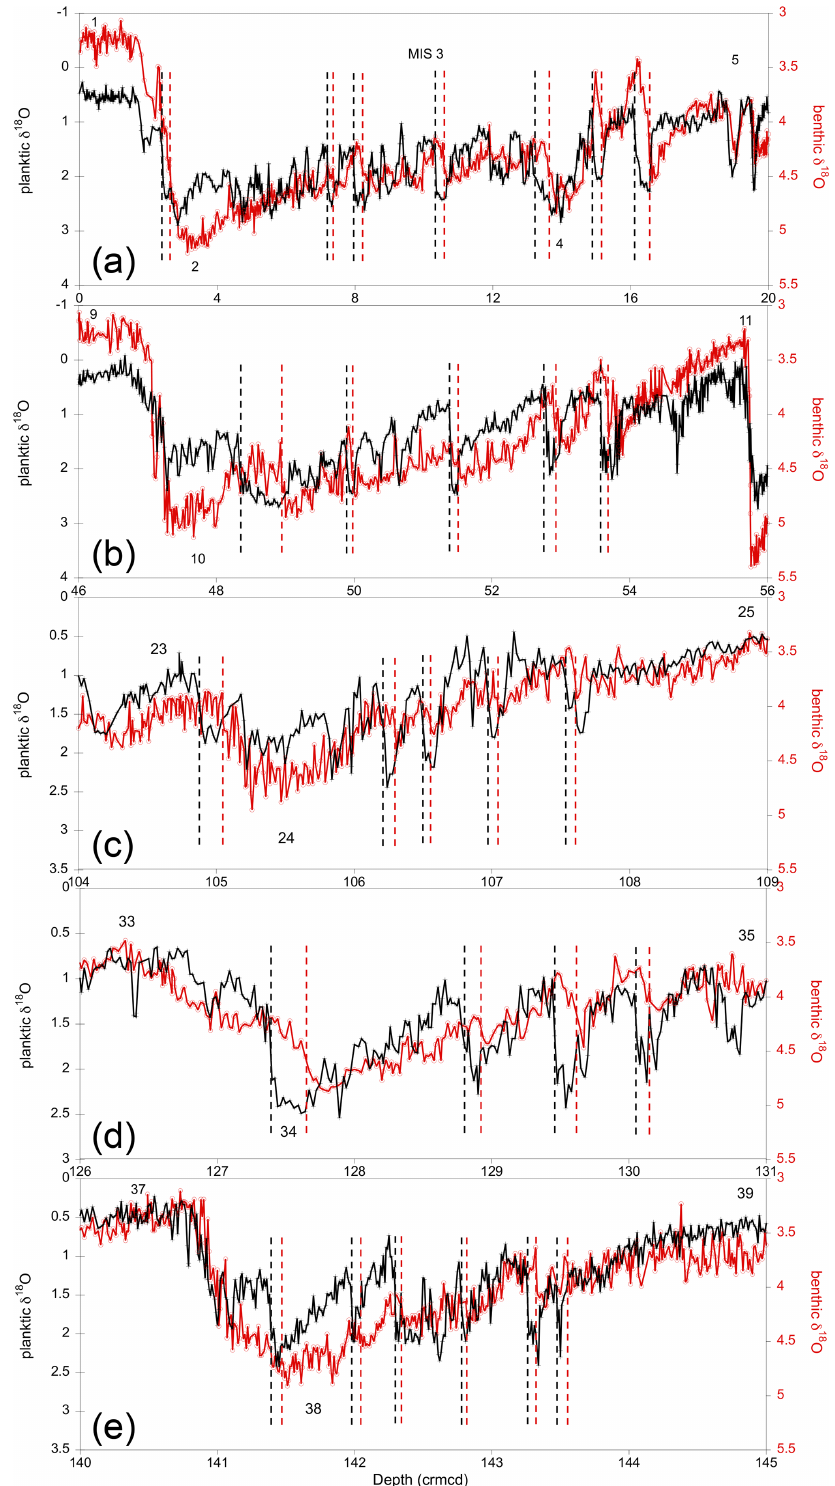
Figure 14. Examples of the phasing of millennial benthic and planktic δ 18 O variability in depth domain: (a) MIS 1–5; (b) MIS 9–11; (c) MIS 23–25; (d) MIS 33–35; and (e) MIS 37–39. The vertical dashed lines mark the rapid warmings (decreases) in the planktic δ 18 O record (black) and decreases in benthic δ 18 O (red). The decrease in benthic δ 18 O occurs prior to the decrease in planktic δ 18 O, which is similar to the phasing observed during MIS 3 ( a and Fig. 2).